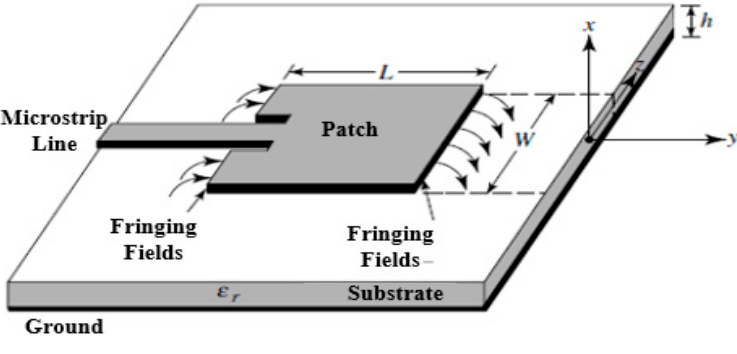
Figure 3. Specification of a planar antenna [8].